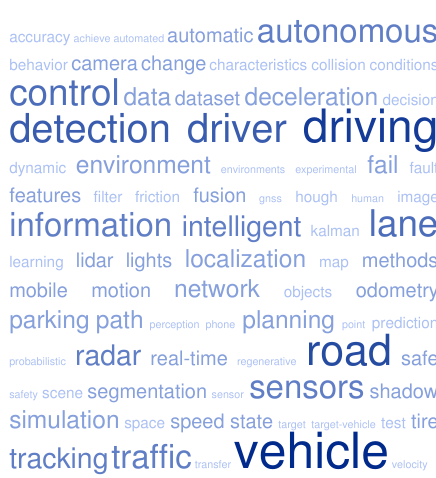
Figure 3. Word cloud from the titles and abstracts of the 32 publications included in the Special Issue (elaborated using